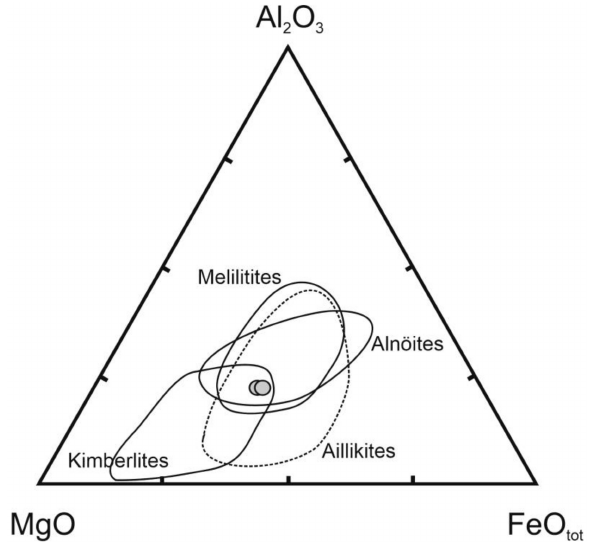
Figure 7. Whole rock compositional field for ultramafic lamprophyre, kimberlite and melilitite rocks (after [38]). Gray circles show data from this study for the Vinoren